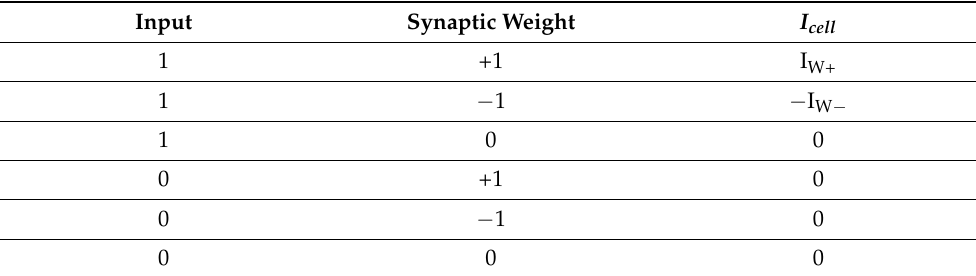
Table 2. Functional truth table of synaptic cells with weights of +1, − 1, and